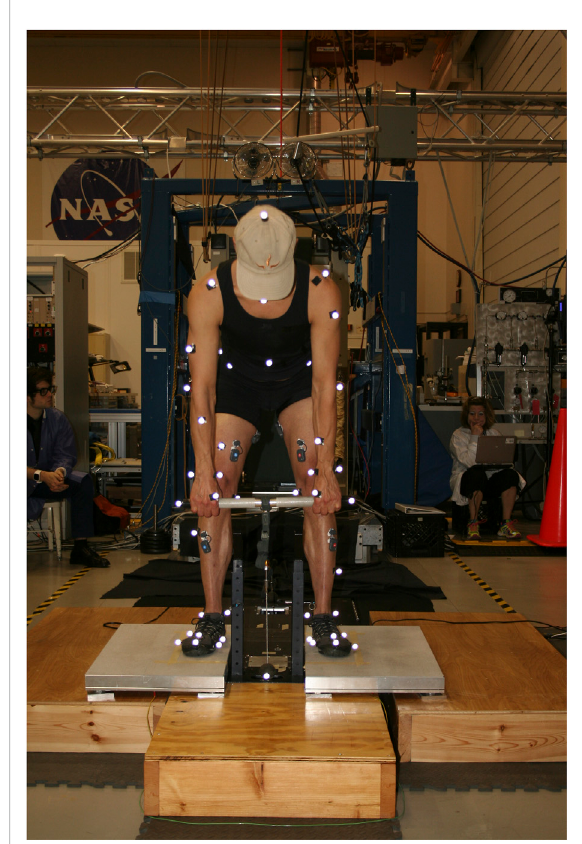
theHULK device.Inaddition, themotioncapture markers areseen covering the upper and lower